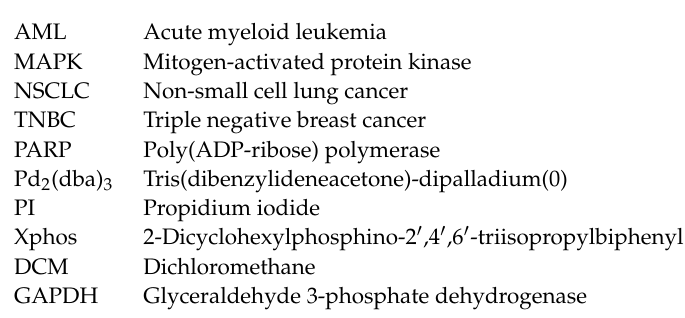
class II/II BRAF mutations and skin fibroblast cells, Figure S1: Quantitative analysis of western blot, Figure S2: FACS analysis after 24 h treatment of SIJ1777 in melanoma cells, Figure S3: Migration inhibitory activity of SIJ1777 against melanoma cells, Figure S4: Invasion inhibitory activity of SIJ1777 against melanoma